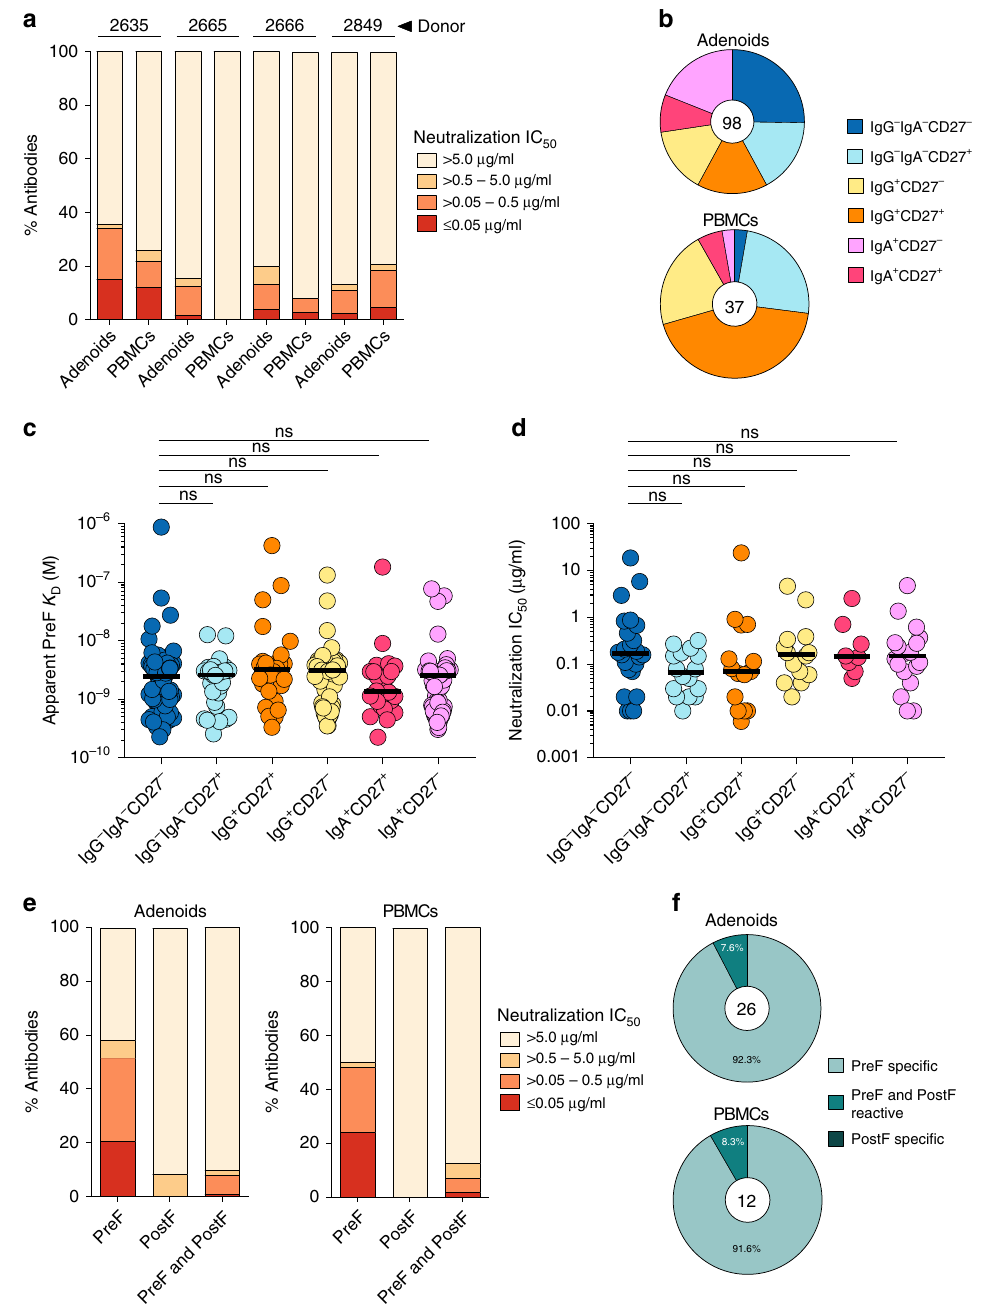
Fig. 4 Neutralizing activity of RSV F-speci fi c antibodies isolated from adenoids and PBMCs. a Percentage of antibodies isolated from adenoids and PBMCs with the indicated neutralization potencies ( n = 808 antibodies). b Pie charts show the distribution of memory B cell subsets from which neutralizing antibodies were isolated. The number in the center of the pie denotes the number of neutralizing antibodies. c Apparent binding af fi nities of adenoid- derived antibodies isolated from each memory B cell subset. d Neutralizing activity of adenoid-derived antibodies isolated from each memory B cell subset. Only antibodies with detectable binding and neutralizing activity are plotted. e Percentage of preF-speci fi c, preF/postF-cross-reactive, or postF-speci fi c antibodies with the indicated neutralization potencies. Antibodies from all donors were pooled for this analysis. f Pie charts show the percentage of highly potent neutralizing antibodies (IC 50 ≤ 0.05 ug/ml) derived from either adenoids or PBMCs that are preF-speci fi c, postF-speci fi c, or preF/postF-cross- reactive. The number in the center of the pie denotes the number of highly potent neutralizing antibodies isolated from adenoids or PBMCs. Statistical comparisons were made using the Mann-Whitney test (n.s. = not signi fi cant). Results are representative of two independent